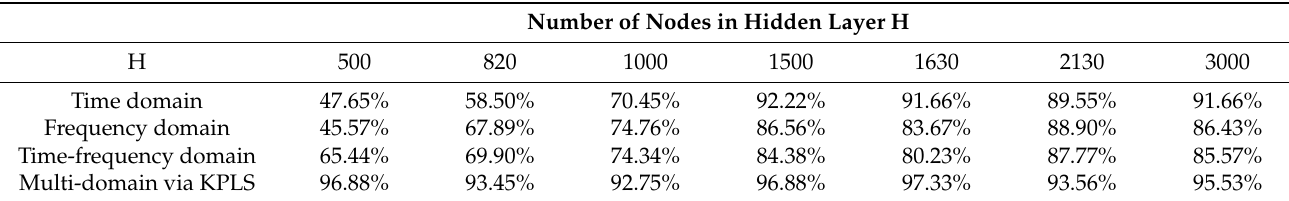
Table 7. Corresponding results for different nodes of hidden layer H.